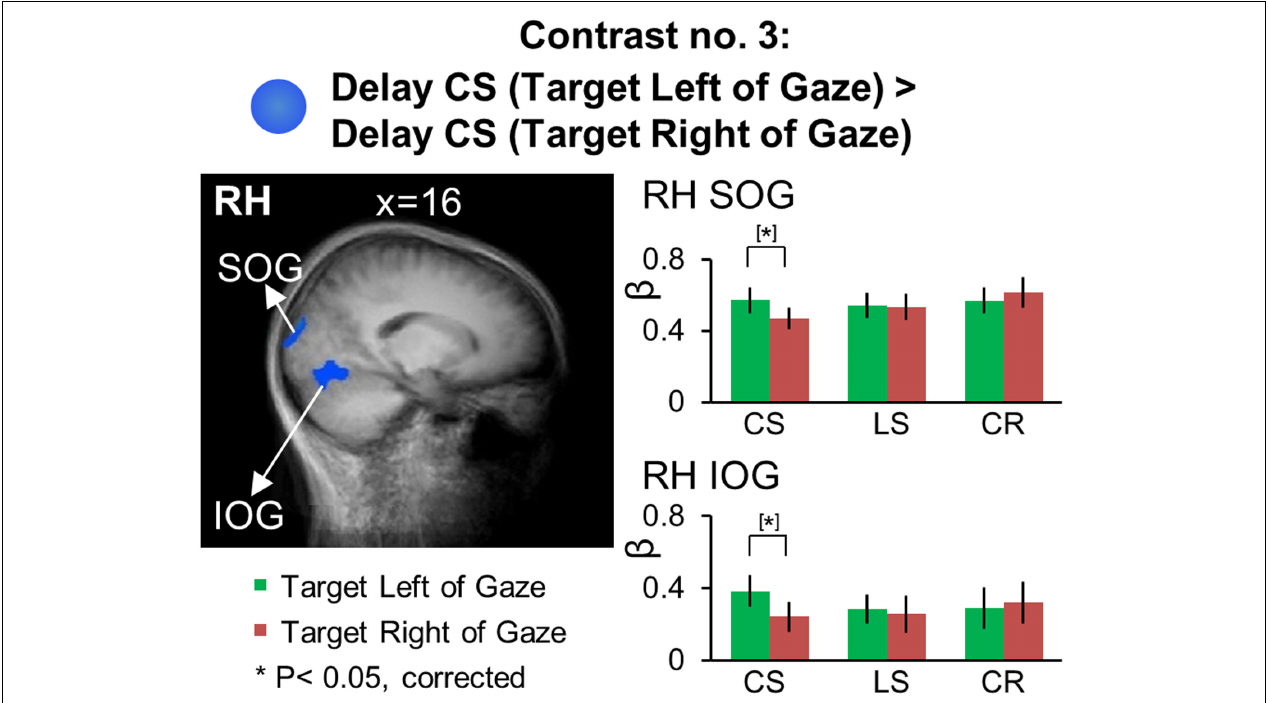
FIGURE 7 | Voxelwise statistical map obtained with the RFX GLM and activation levels for each area using Contrast no. 3, [Delay CS: (Target Left of Gaze) > Delay CS: (Target Right of Gaze)]. Left panel: activation map overlaid on the averaged anatomical image from all participants. Right panel: bar graphs show the β weights for each condition in each area. Legends as in Figure 2